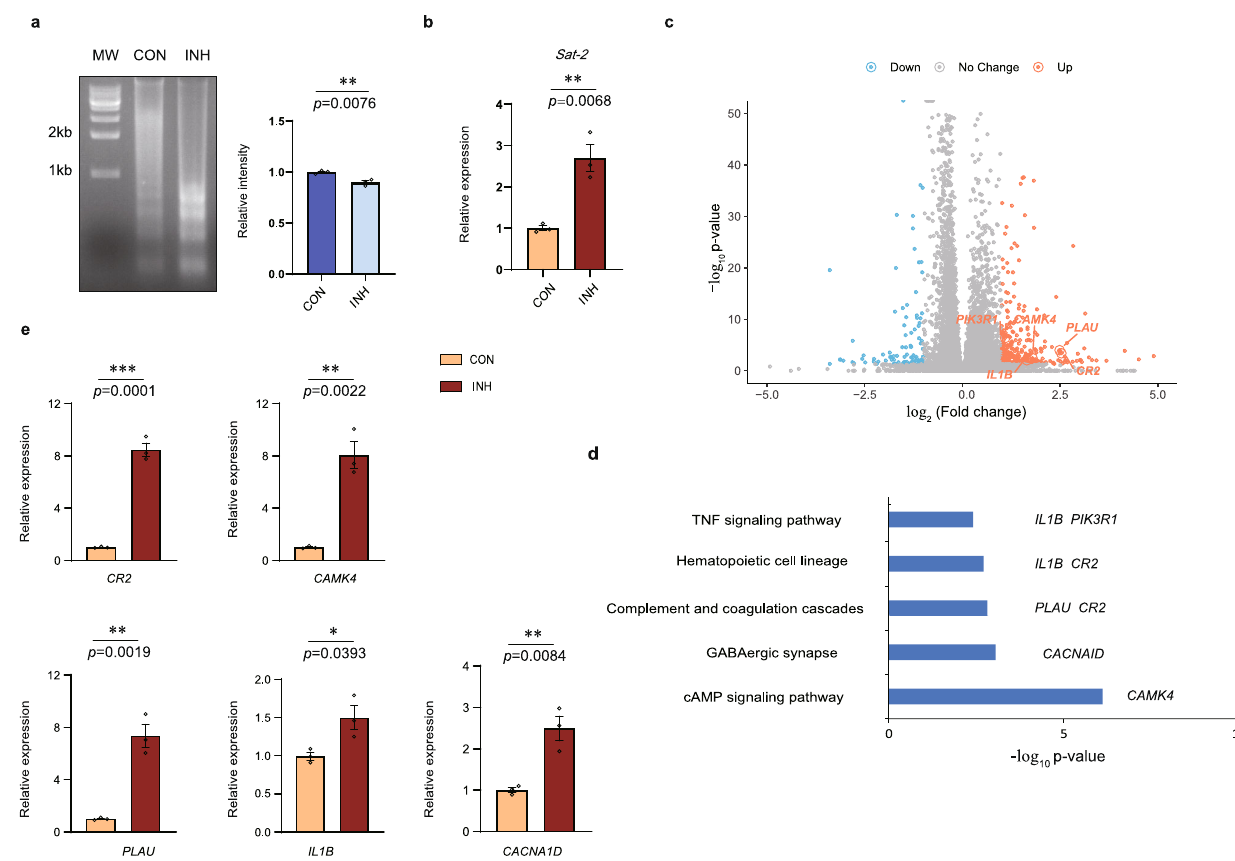
Fig. 5 Histone K inic leads to higher chromatin accessibility and promotes gene transcription. a , b Histone K inic induces chromatin accessibility. a HepG2 cells were treated with or without 10 mM INH for 6 h, nucleosomal DNA was extracted and analyzed by MNase sensitivity assay (left). “ CON ” indicates untreated HepG2 cells; “ INH ” indicates isoniazid treated HepG2 cells, MW: Molecular Weight. Quanti fi cations of lane signal intensity (right, upper bands), data presented are the mean ± SEM from three biological replicates ( n = 3), as determined by unpaired two-tailed Student ’ s t- test b Relative mRNA expression of Sat-2 in HepG2 cells treated with or without 10 mM INH for 12 h and determined by real-time RT-PCR assay, “ CON ” indicates untreated HepG2 cells; “ INH ” indicates isoniazid treated HepG2 cells, data presented are the mean ± SEM from three biological replicates ( n = 3), as determined by unpaired two-tailed Student ’ s t- test. c Histone K inic upregulates 313 genes and downregulates 121 genes. Volcano plot analysis of pairwise comparison of RNA-seq results from HepG2 cells with or without 10 mM INH for 12 h ( n = 3 samples, values were expressed as mean ± SEM). d KEGG pathway analysis of mRNA levels elevated genes. Some genes involved in each pathway are labelled. e Real-time RT-PCR analysis of the genes labelled in KEGG pathway analysis. Relative expression is normalized to GAPDH, “ CON ” indicates untreated HepG2 cells; “ INH ” indicates isoniazid treated HepG2 cells, data presented are the mean ± SEM from three biological replicates ( n = 3), as determined by unpaired two-tailed Student ’ s t-